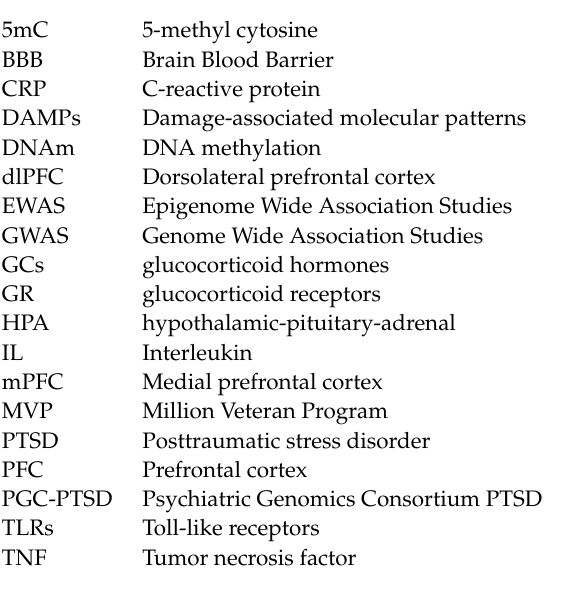
results; Table S4: List of selected genes stratified by brain and peripheral samples; Table S5: Drug development